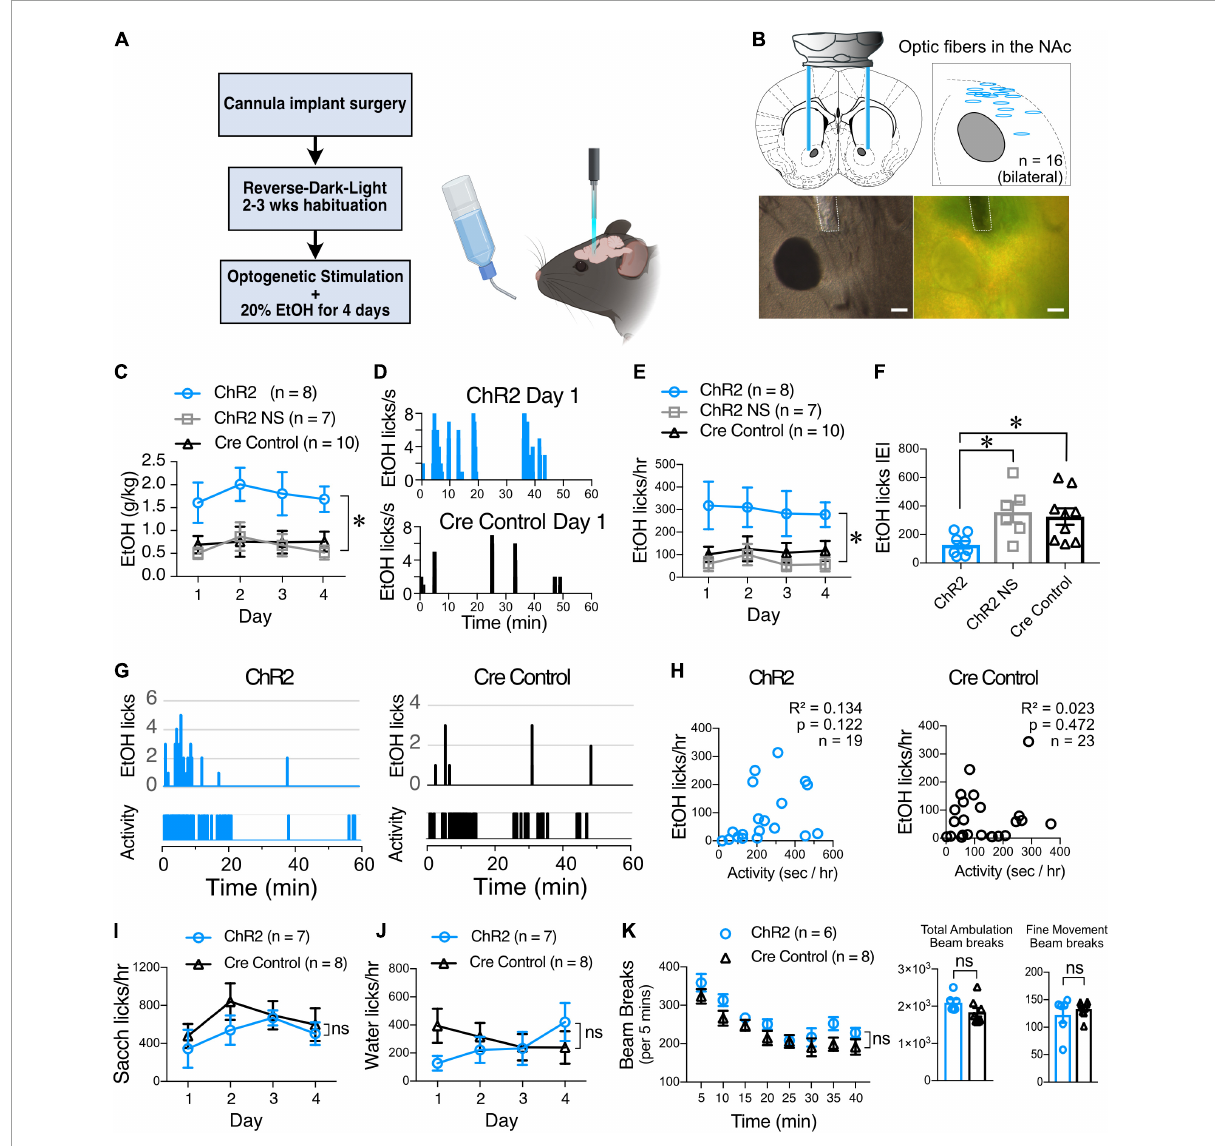
FIGURE7 ChI optogenetic stimulation increases EtOH consumption. (A) Schematic of the DID behavioral experiment. ChAT.ChR2 and ChAT.cre mice underwent fiber optic implant in the NAc surgery at 4–5 weeks of age, recovered and habituated to reverse-dark-light schedule. ChAT.ChR2 and ChAT.cre mice were optogenetically stimulated during 4 days of 20% alcohol exposure and tethered to the fiber cord while ChAT.ChR2 not stimulated (NS) mice were only tethered to the fiber cord. (B) Schematic of the bilateral optic fiber cannula implant in the NAc (top left panel), locations of bilateral implants in 8 ChR2 mice that were used for the experiment (top right panel), example image of cannula placement in DIC (bottom left panel), and fluorescent light (bottom right panel). (C) Average daily alcohol consumption over 4 days in optically stimulated ChR2 mice (ChR2), non-stimulated ChR2 mice (ChR2 NS), and stimulated ChAT-cre mice (Cre controls). (D) Graphs of alcohol licks during 1 h period in representative stimulated (top graph, blue bars) and non-stimulated ChR2 mice (bottom, gray bars). (E) Daily average of alcohol licks over 4 days of alcohol exposure in optically stimulated ChR2 mice (ChR2), non-stimulated ChR2 mice (ChR2 NS), and stimulated ChAT-cre mice (Cre controls). (F) Frequency of alcohol licks as measured by average licking bout inter-event interval (IEI) per mouse over a 4-day period. (G) Representative plots of mouse activity as measured by passive infrared (PIR) activity monitoring system and corresponding EtOH licks in ChR2 (Left graphs, blue bars) and Cre control mice (right graphs, black bars). (H) The number of licks is not correlated with mice locomotor activity in ChR2 (blue symbols) and Cre control groups (black symbols). (I) Saccharine consumption measured as number of licks/hr over 4 days in 1 h-long optogenetically stimulated ChR2 (blue circles) and Cre control mice (black triangles). (J) Water consumption measured as number of licks/hr over 4 days in 1 h-long optogenetically stimulated ChR2 and Cre control mice. (K) Ambulatory activity test of ChR2 and Cre control mice during ChI optogenetic stimulation. Ambulation time course shows average beam breaks every 5 min for 40 min of the test. Total ambulation shows the total beam breaks in 40 min, fine movement shows grooming activity and vertical ambulation shows rearing activity. * p < 0.05, ns, no significant